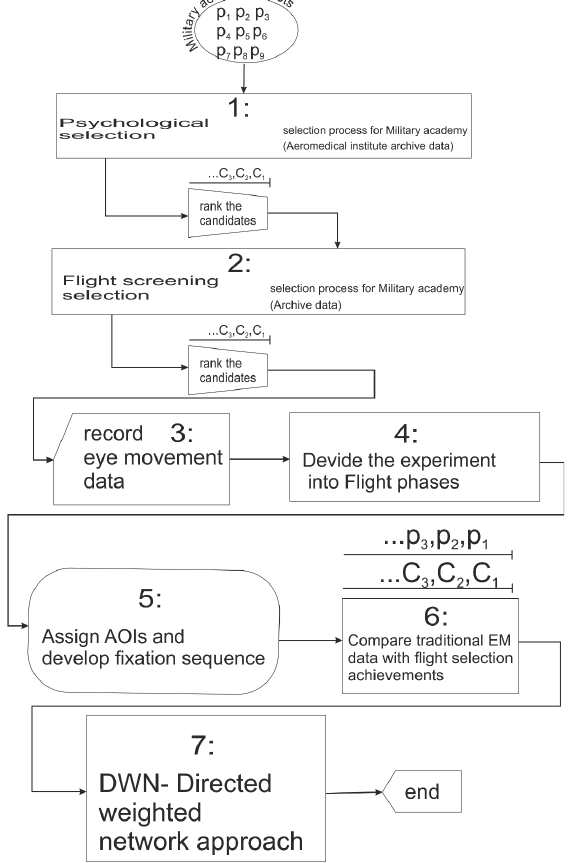
Figure 4. Flowchart of selection process and connec- tion with eye movement research